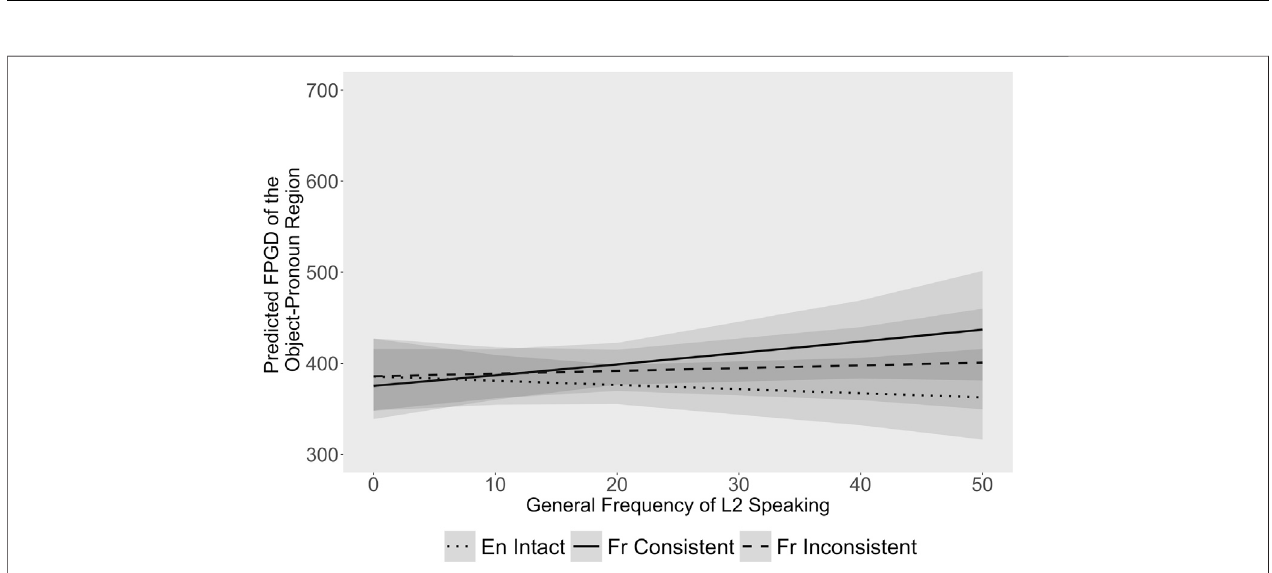
FIGURE6| Experiment 2(English-FrenchbilingualsreadinginL1),interaction effect ofgeneralfrequencyofL2speaking(out of100%)onpredicted fi rstpassgaze duration (in ms) of the object-pronoun region. Shaded area represents plus/minus one standard error of the mean.